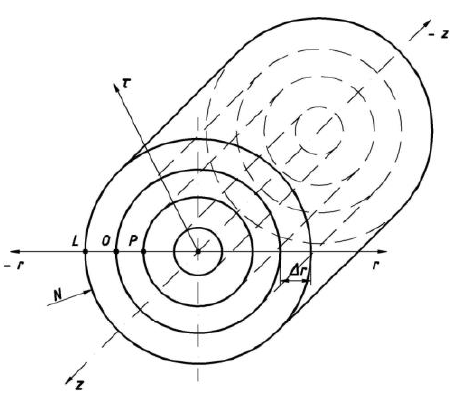
Figure 14. Balance diagram of the model.